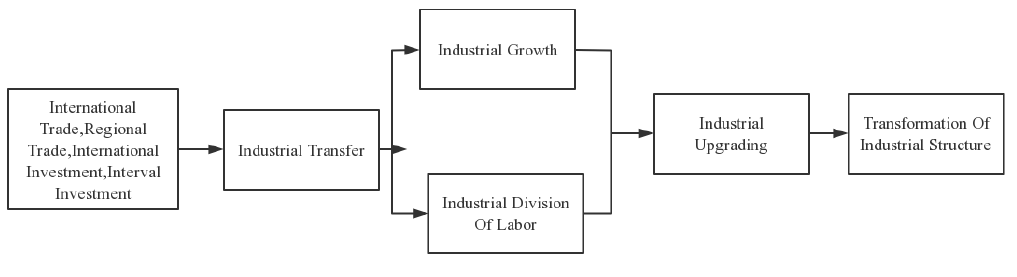
Fig. 1 Mechanism analysis diagram of industrial transformation